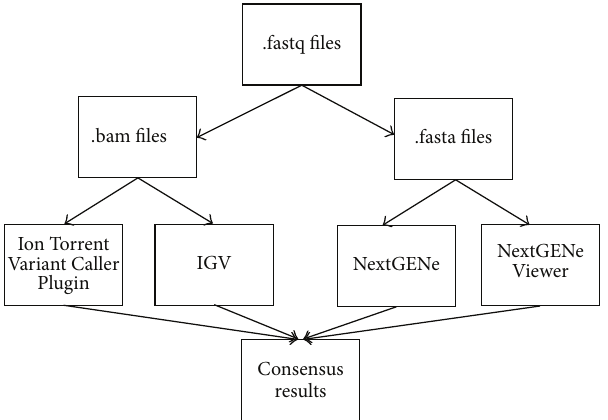
Figure 1: Analysis pipeline of sequencing data. Identification of variants was performed using two parallel analysis tools: Ion Torrent Variant Caller Plugin version 4.0 (Life Technologies) with visual inspection of the read alignment on the Integrative Genomics Viewer (IGV, Broad Institute, Boston, MA) and NextGENe software package version 2.3.4 (SoftGenetics, State College, PA) with the read alignment directly inspected on the NextGENe Viewer.